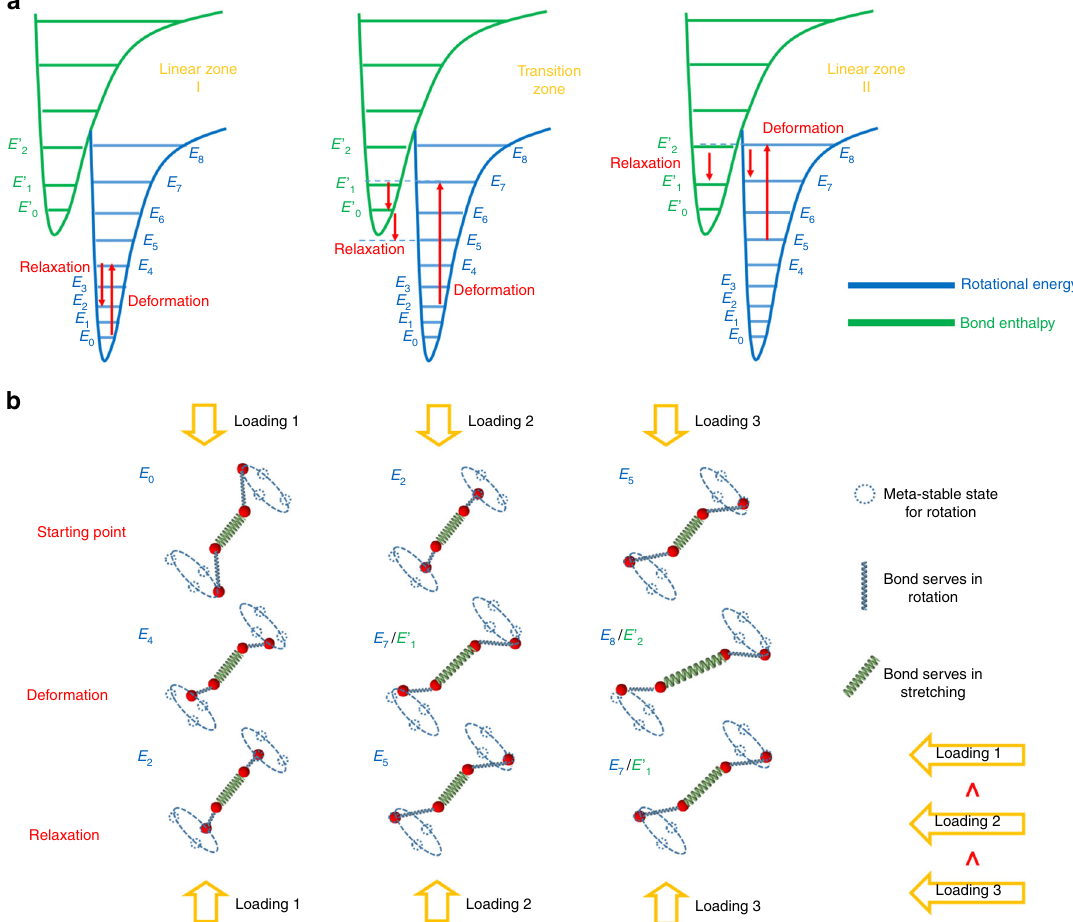
Fig. 3 The energetical, structural, and conformational characteristics. During compression programming, the energetical, structural, and conformational evolution can be characterized by: a the energetical evolution corresponding to linear zone I (LZ1), transition zone (TZ), and linear zone II (LZ2). Deformation excites the energy to a higher level, most likely an unstable energy state; and after structural or stress relaxation, retreats to a local lower energy level, leading to meta-stable state. For example, in the LZ2, deformation excites the rotation energy level from E 5 to E 8 , and relaxation retreats the energy level in terms of bond enthalpy to E 1 ′ . b The structural and conformational evolution corresponding to LZ1, TZ, and LZ2. The blue springs stand for rotating bonds and the green springs represent stretching bonds. The dashed circles are the possible locally meta-stable positions for the rotating bonds. Under loading 1, only bond rotation happens during both deformation and relaxation. Under loading 2, which is larger than loading 1, both bond rotation and stretching can happen during the deformation. However, the stretched bonds retreat during the relaxation. Under loading 3, which is the highest loading, the stretched bond can be stabilized in a certain conformation. The simpli fi cation made here is that the rotating bonds (blue springs) are fi xed length during the deformation and the relaxation. The reality is that the rotating bonds can also be Characterization of enthalpy release . Figure 2 con fi rms enthalpy release during free shape recovery by differential scanning calorimetry (DSC) tests. Two thermal cycles were conducted for the un-deformed (control) and 40% compression strain pro- grammed samples. Both samples show the same glass transition region in the second heating curve, because the fi rst heating cycle has eliminated the history of programming. For the programmed sample, a high enthalpy release is con fi rmed by the inverse peak presenting in the fi rst heating curve. The release starts at the on- set point of the glass TZ sharply. Considering both the baseline shift and the normal glass transition (Supplementary Fig. 4), the total speci fi c enthalpy released by the stretching bond is − 2.85 J/g. The negative sign means energy release. Considering that the density of the sample is 1.142 g/cm 3 , the enthalpy release density is 3.25 MJ/m 3 . Compared with the total energy stored in the 40% pre-strain programmed sample, which is 3.59 MJ/m 3 calculated by integration from 0 to 40% strain in Fig. 1d, it is found that 90.5%